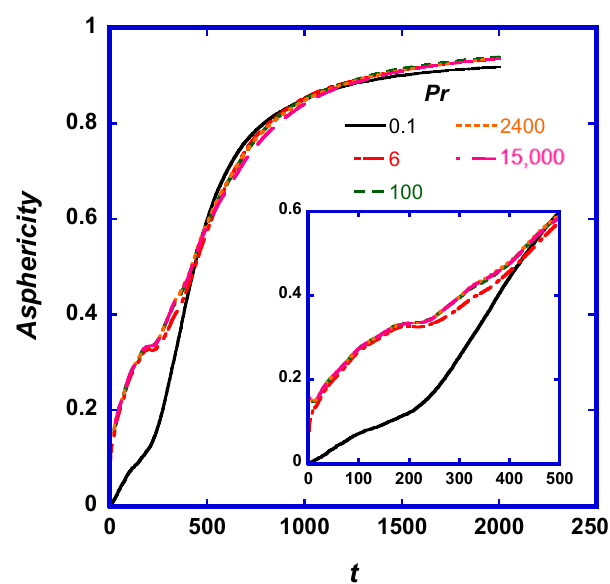
Figure 4. Asphericity of puff shapes as a function of time and Pr . At times less than 50, the value of asphericity is less than 0.2, but increases at larger times.